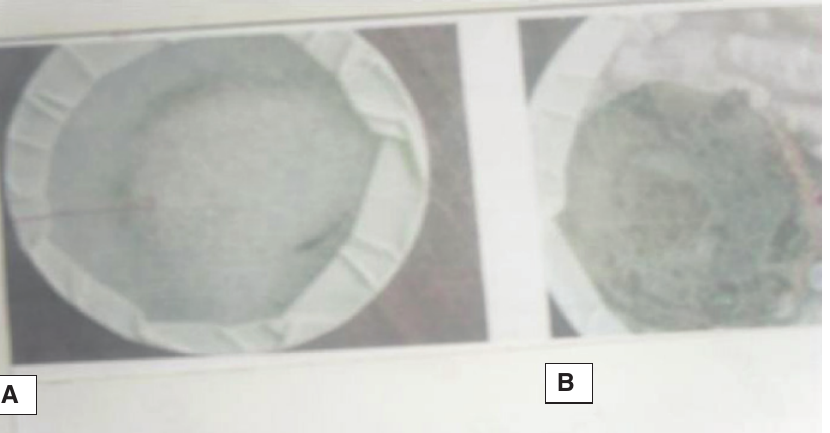
Figure 6: Photograph of untreated tuber (A) and tuber treated with AgNeemnano solution (B) against Fusarium moniliforme and Lasiodiplo- dia theobromae.